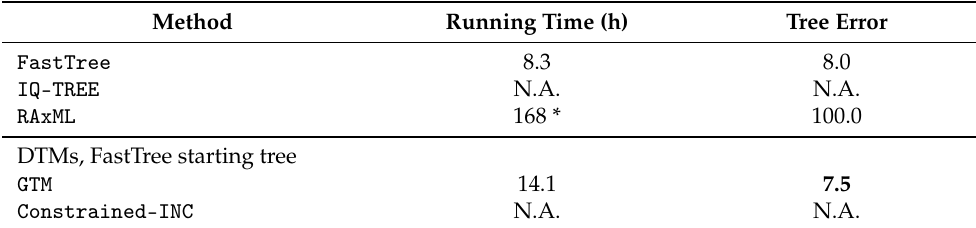
Table 7. Results on the RNASim50k datasets. The average running time (in hours) and tree error (FN) rates over 10 replicates. Running time assumes that each method was run with 16 cores. Each method was given 64 GB. “N.A.” indicates a failure to produce a tree due to a memory allocation problem. The asterisk (*) for RAxML running time indicates that it had not been completed by that time, and we used the best scoring tree it found in that time period. The most accurate result is boldfaced. Method Running Time (h) Tree Error FastTree 8.3 8.0 IQ-TREE N.A. N.A. RAxML 168 * 100.0 DTMs, FastTree starting tree GTM 14.1 7.5 Constrained-INC N.A.